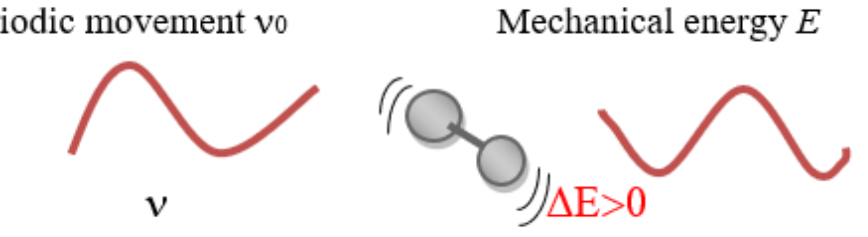
Figure 1. Classic diagram of the absorption of electromagnetic energy converted into mechanical energy.